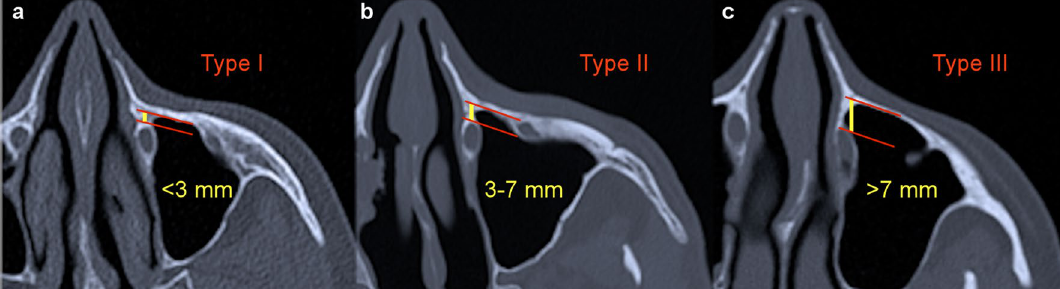
Figure 2. Simmen’s feasibility classification according to the distance between the anterior maxillary sinus wall and the anterior border of the nasolacrimal duct. ( a ) Type I (< 3 mm). ( b ) Type II (3–7 mm). ( c ) Type III (> 7